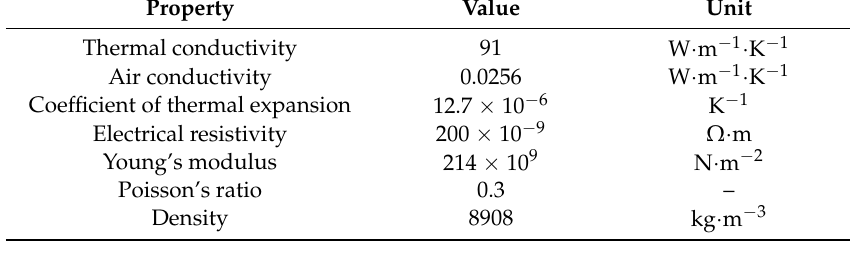
Table 2. The material properties used for thin-film Nickel in FEM based simulations [36].